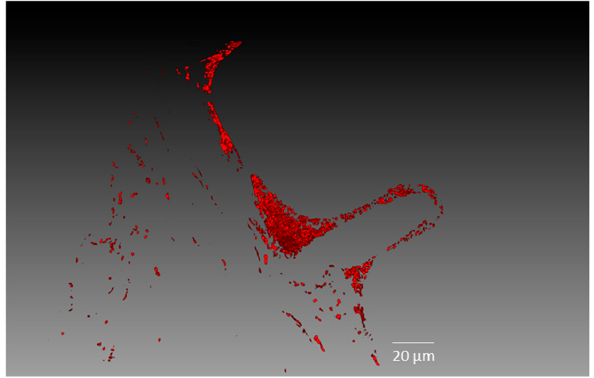
Figure 3. Confocal microscopy picture in the red-channel with mCherry-tagged Methylobacterium sp. Cp3 lining the root hair surface of Crotalaria pumila in medium supplemented with Zn and Cd.